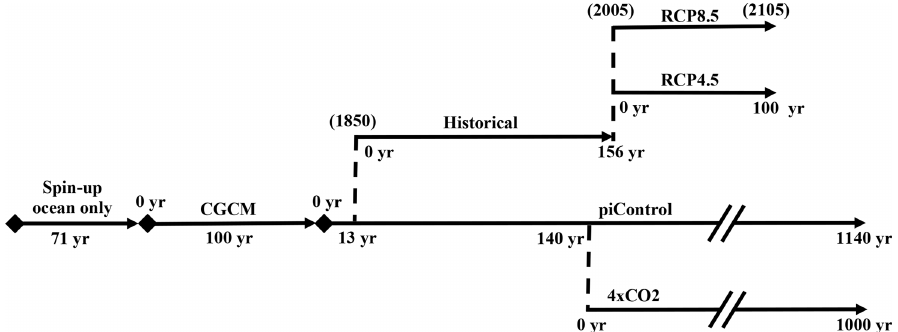
Figure 1. A scheme of the principal simulations carried out by BESM-OA2.5 using different forcing conditions based on the CMIP5 protocols. The dates for the historical and RCP simulations are from the actual calendar years.